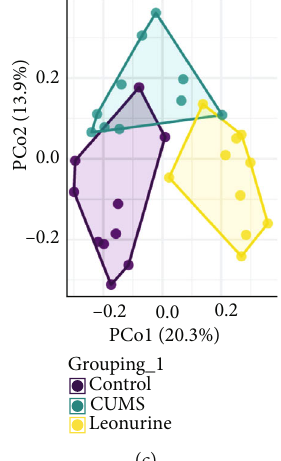
Figure 3: The e ff ects of leonurine on gut microbiota in CUMS rats. (a) Veen diagram: microbiota comparison of Control, CUMS, and Leonurine groups. (b) Alpha diversity analysis. (c) PCoA